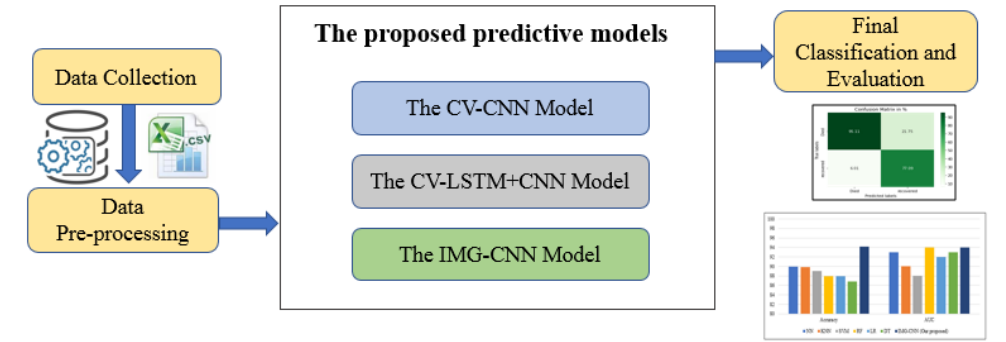
Figure 1. Block diagram of the proposed predictive models